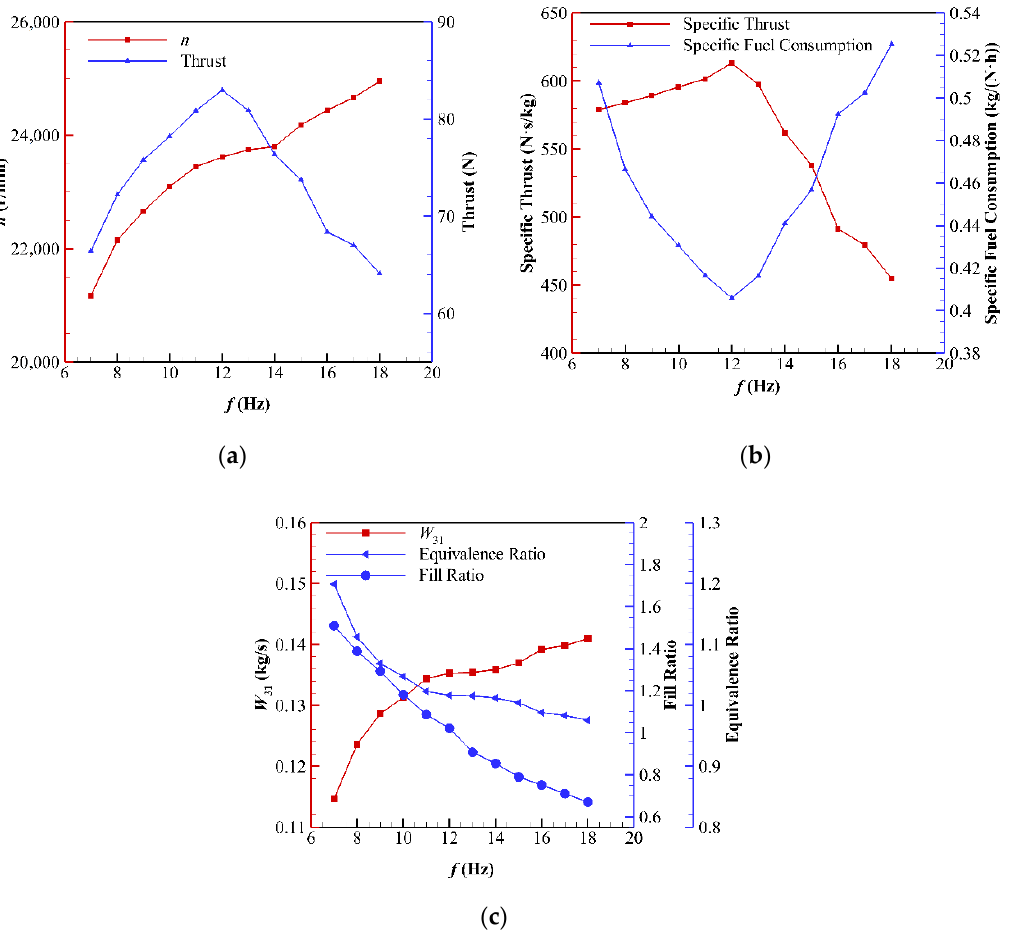
Figure 6. Operating characteristics of PDTE under different firing frequency. ( a ) Rotor speed and thrust vs. f . ( b ) Specific fuel consumption and specific thrust vs. f . ( c ) Mass flow rate, equivalence ratio, and fill ratio vs. f .